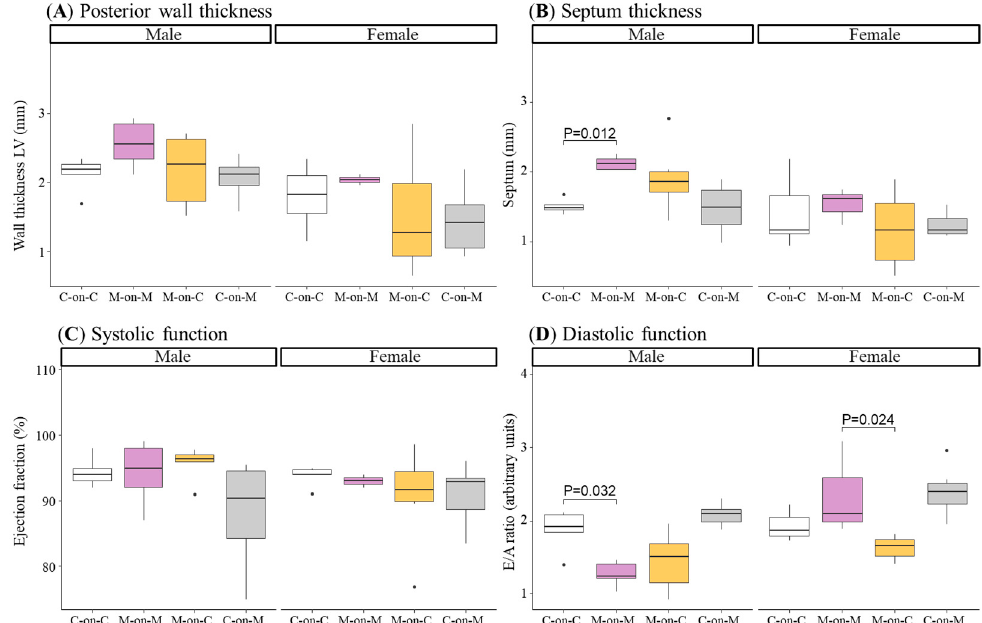
Figure 5. Posterior wall thickness ( A ), septum thickness ( B ), ejection fraction ( C ), and E/A ratio ( D ) of 21-day-old male and female offspring from MUN and Control mothers. MUN, maternal undernutrition during gestation; C-on-C, control pups fostered by their mothers (6 males and 6 females); M-on-M, MUN rats fostered by their mothers (6 males and 6 females); C-on-M, control rats fostered by MUN mothers (6 males and 6 females); M-on-C, MUN rats fostered by a control mother (6 males and 6 females); LV, left ventricle. Data show the median and interquartile range [Q1; Q3], and the showed p -Value (P) was extracted from Dunnett´s post-hoc pairwise comparison test when the Kruskal-Wallis test was p <0.05. Dots show outliers.